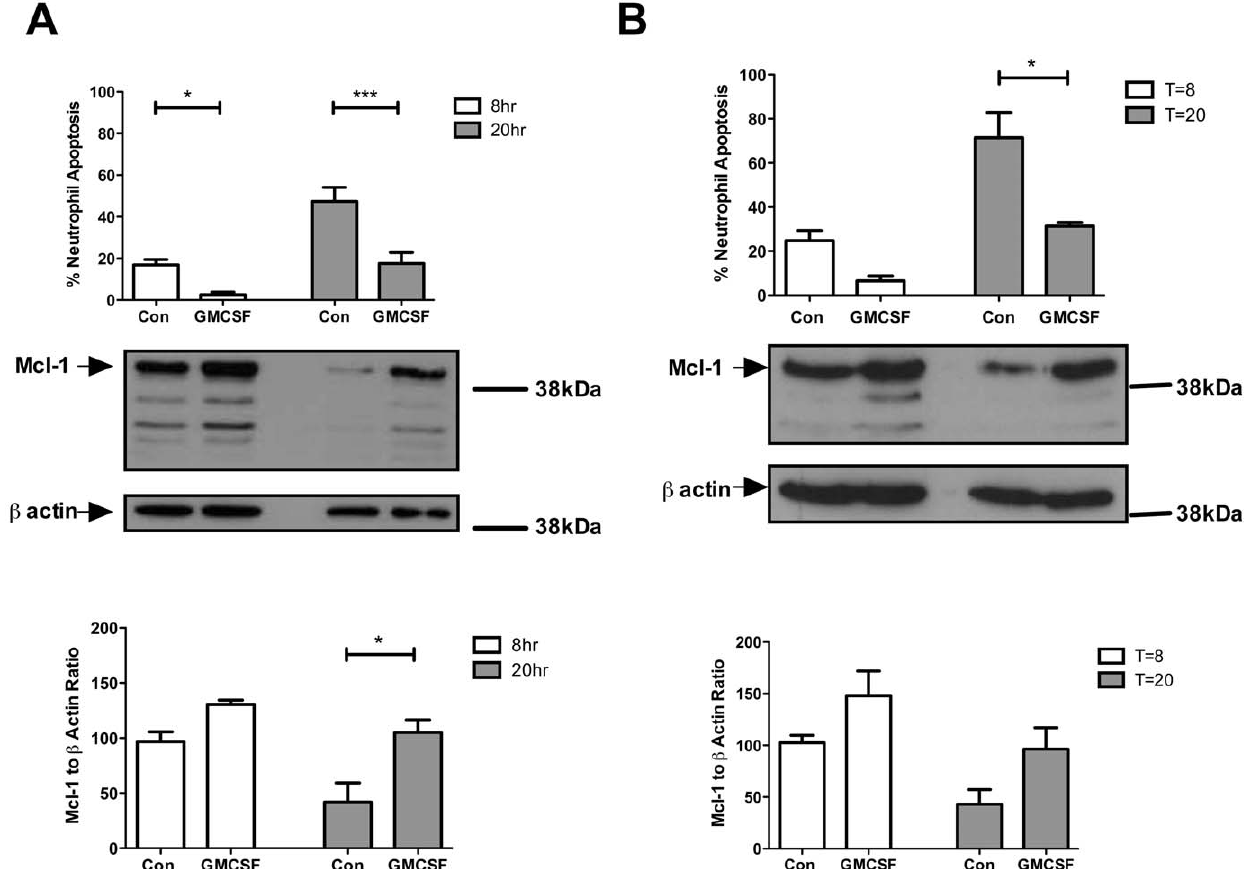
Figure 4. GM-CSF increased Mcl-1 levels in standard purity and highly purified neutrophils between 8 and 20 hours. A . Rates of apoptosis (top) and Mcl-1 expression 6 GM-CSF as determined by western blot analysis in neutrophils isolated using the Percoll method. n=3 independent experiments from different donors. *P , 0.05, *** p , 0.001, one-way ANOVA, with Bonferroni’s post-test correction for multiple comparisons. B . Rates of apoptosis (top) and Mcl-1 expression 6 GM-CSF as determined by western blot analysis in neutrophils isolated using the OptiPrep ( + NMS) method. n=3 independent experiments from different donors. *P , 0.05 one-way ANOVA, with Bonferroni’s post-test correction for multiple